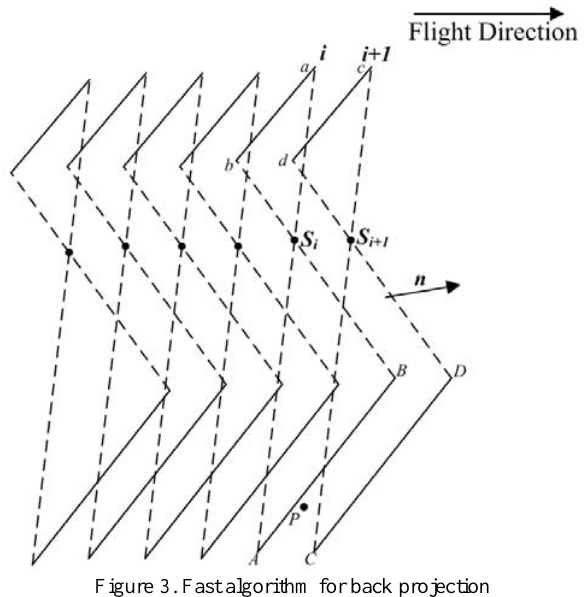
Figure 3. Fast algorithm for back projection